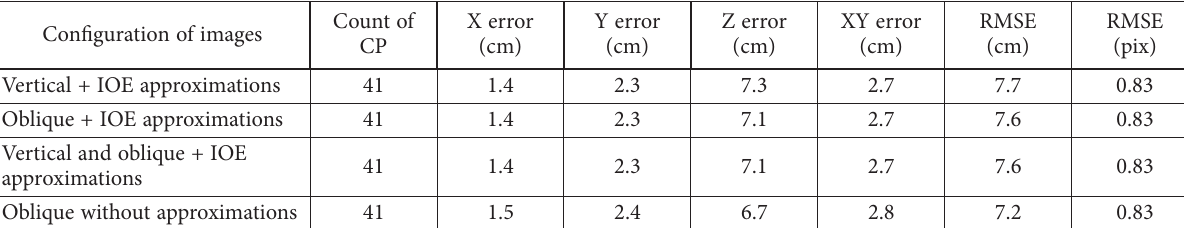
Table 4. Visualization of the distribution of errors in fitting the model to GCP after aligning the control image block using the obtained elements of internal orientation as exact approximations and a variant without approximations Count of Configuration of images GCP Vertical + IOE approximations Oblique + IOE approximations Vertical and oblique + IOE approximations Oblique without approximations